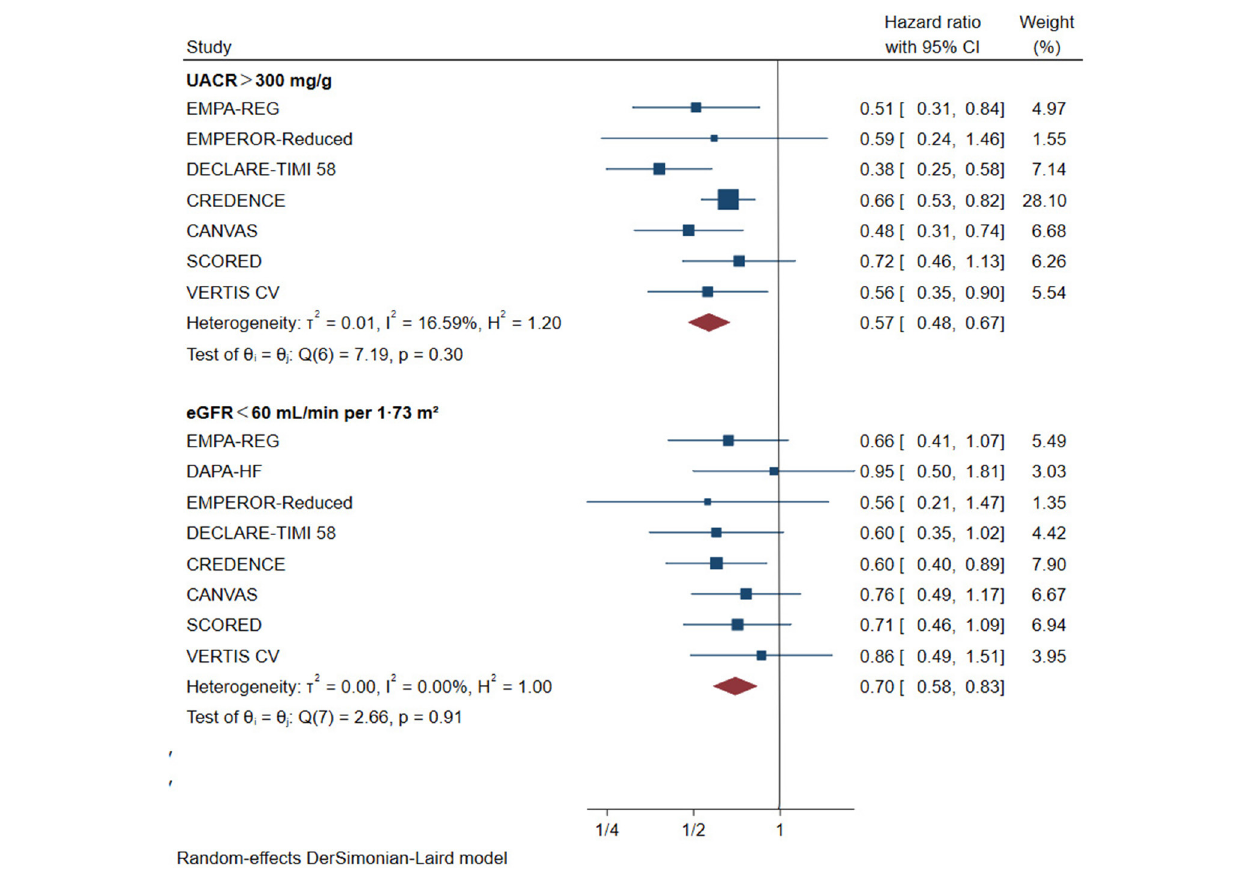
FIGURE 2 | Effect of SGLT2 inhibitors on ESKD, worsening kidney function, or death because of kidney disease. CI, confidence interval; UACR, urinary albumin-to-creatinine ratio; eGFR, estimated glomerular filtration rate. Worsening kidney function: defined as doubling of serum creatinine or sustained 40% decline in eGFR; ESKD, defined as requirement for chronic dialysis or kidney transplantation, or sustained eGFR < 15 mL/min/1.73 m ² .